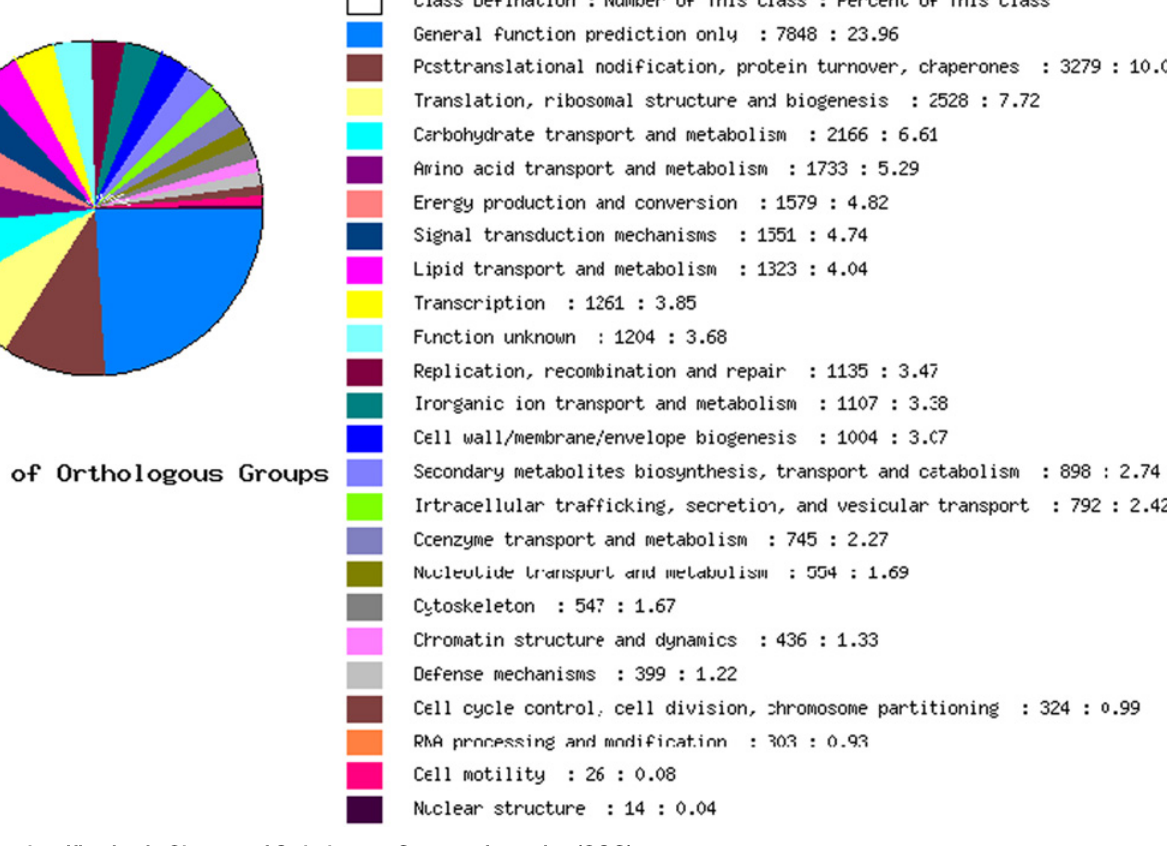
Fig 5. Function classification in Clusters of Orthologous Groups of proteins (COG).